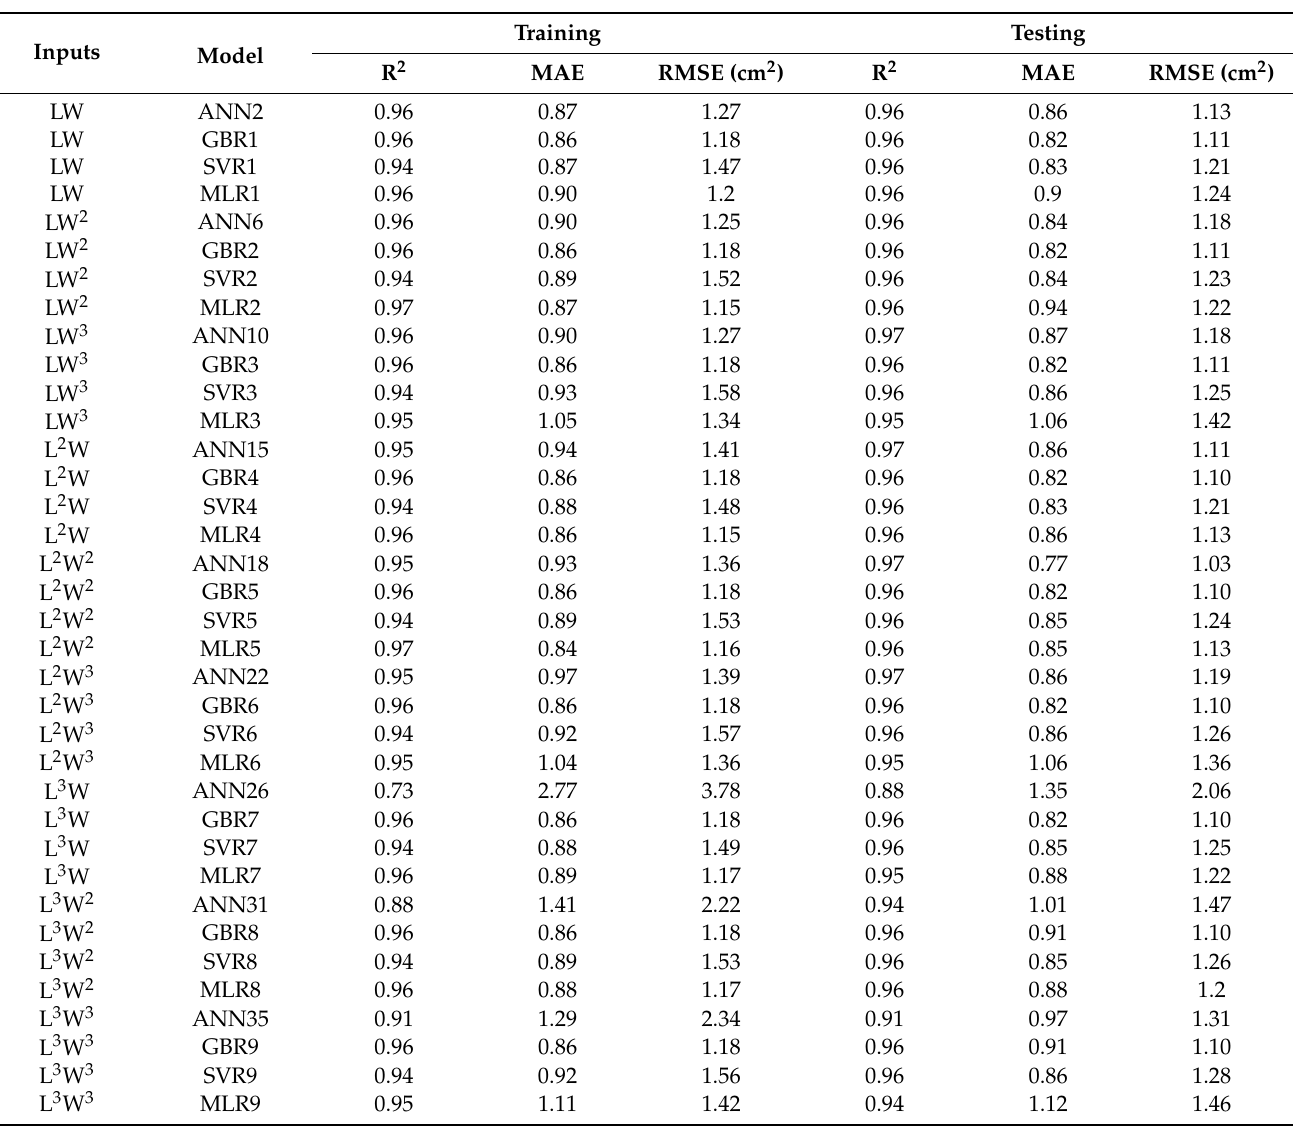
Table 8. Comparative statistical performance analysis of MLR, SVR, GBR, and ANN with